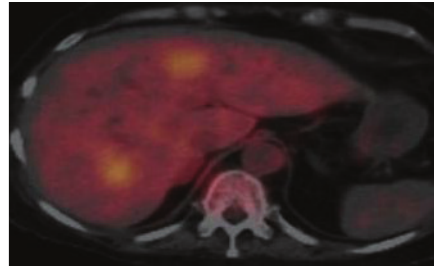
Figure 3: Liver metastasis (PET/CT).